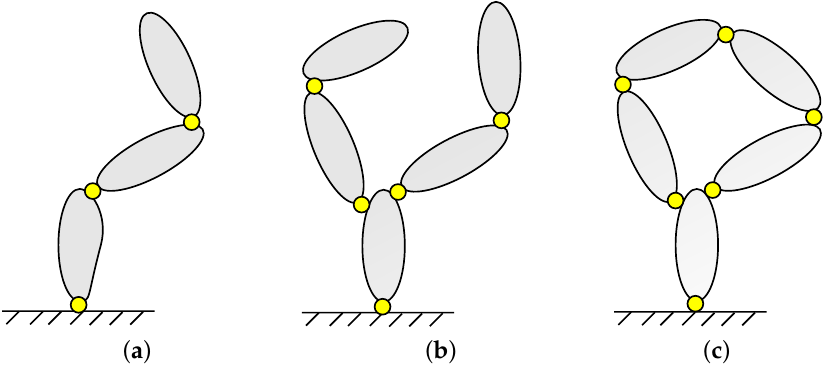
Figure 1. Typical topologies of multibody systems. ( a ) Open-loop topology; ( b ) Tree topology; ( c ) Closed